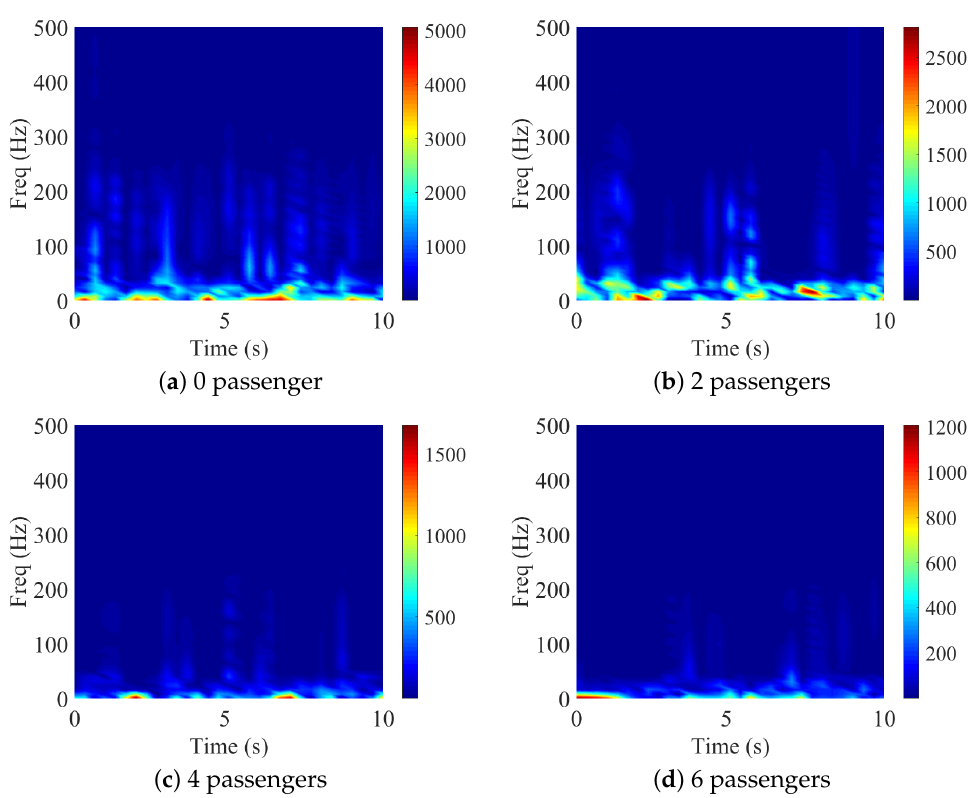
Figure 7. Comparison of spectrograms for different numbers of